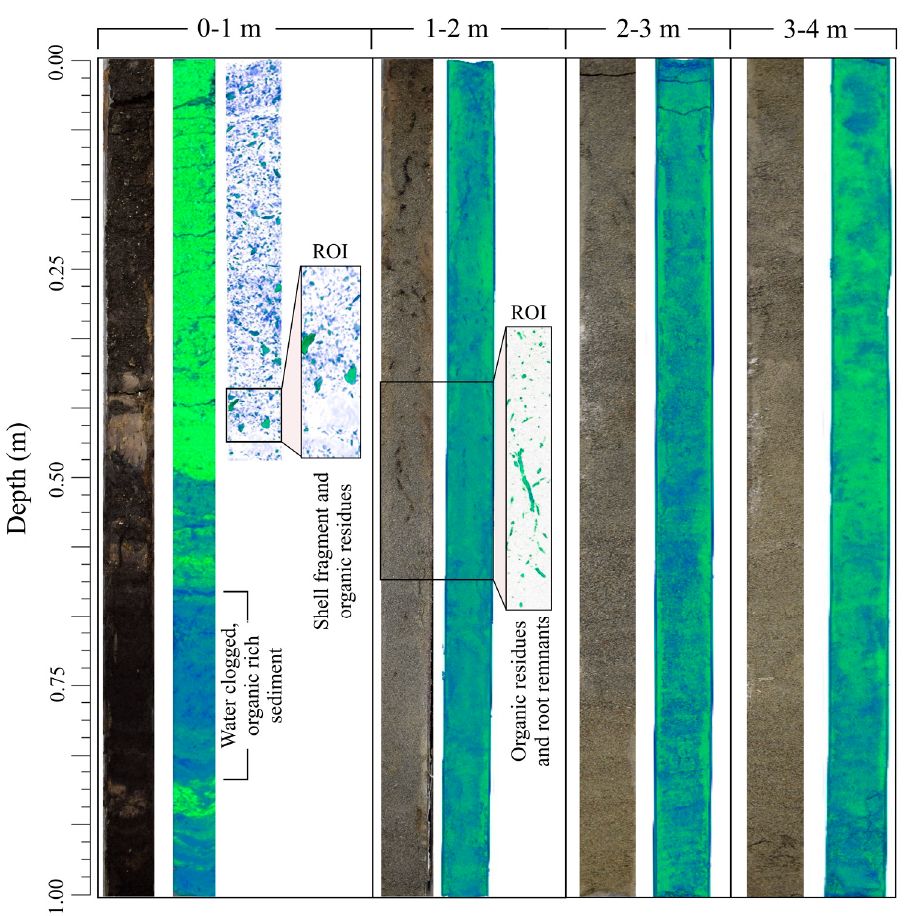
Figure 8. Three-dimensional model of core AG with additional regions of interest (ROI) highlighted in boxes. Additional HU boundaries were attached in all regions in order to better visualize organic residues, shell fragments,